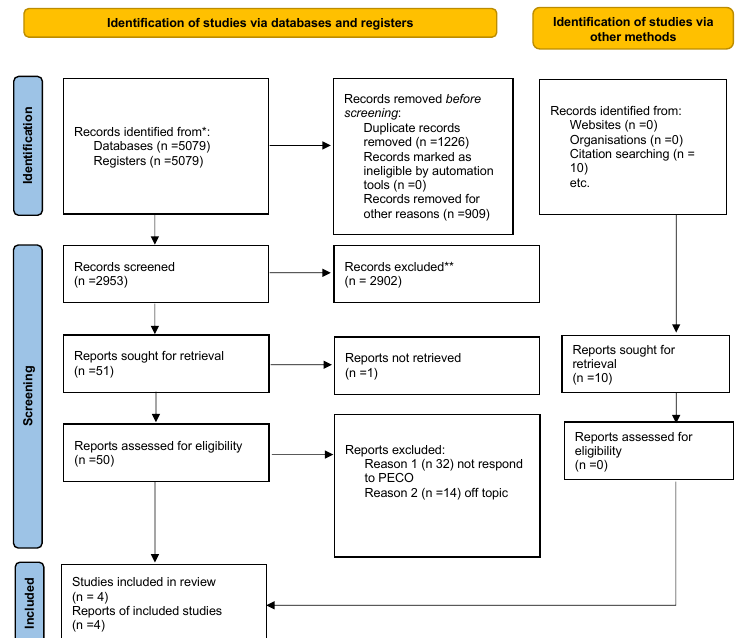
Figure 1. Prisma Flowchart. * papers identified by search methods; ** papers removed because systematic reviews of the literature. Table 2. Main characteristics of the studies included in the present systematic